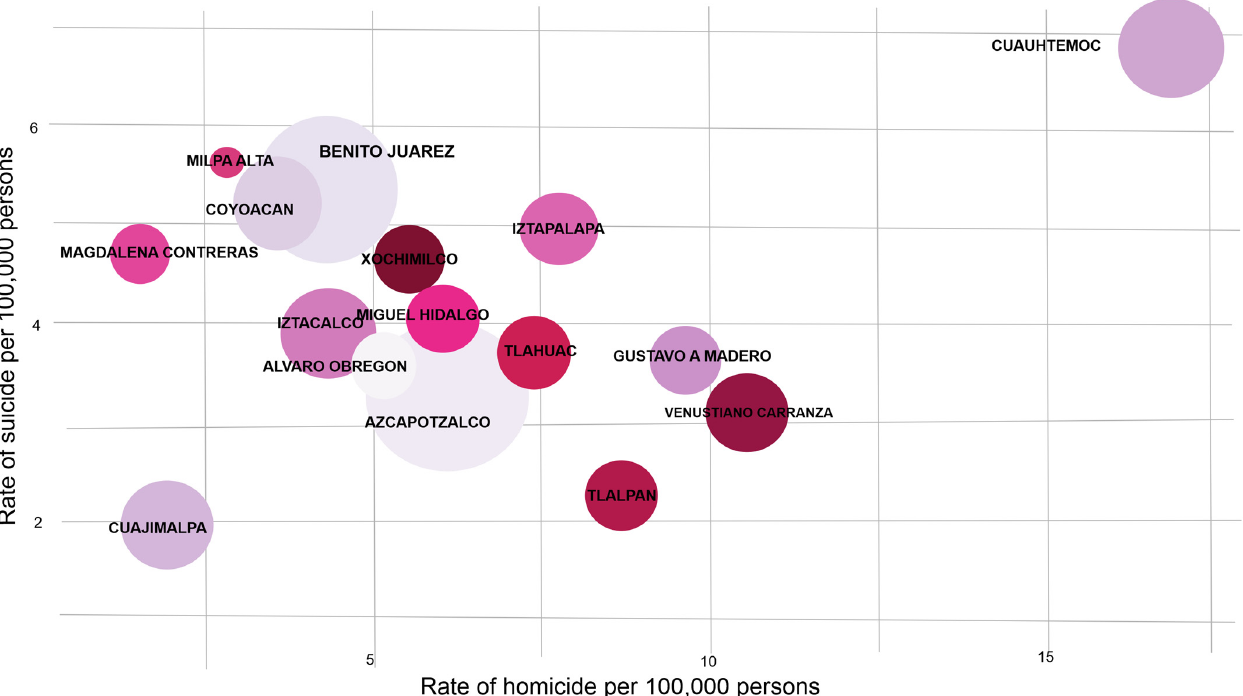
The homicide rate for men in Mexico City was 32.96 per 100,000 males in 2019. In this sense, Venustiano Carranza Municipality showed the highest homicide rate in men (131.72 per 100,000 males), but it had the lowest suicide rate with 9.92 per 100,000 males. Whereas in Milpa Alta Municipality the highest suicide rate was 29.6 suicides per 100,000 males. Therefore, the homicide ratio by sex is 7.8:1 in men compared to women, and the suicide ratio by sex was 4.2 men for every woman Figure 3.